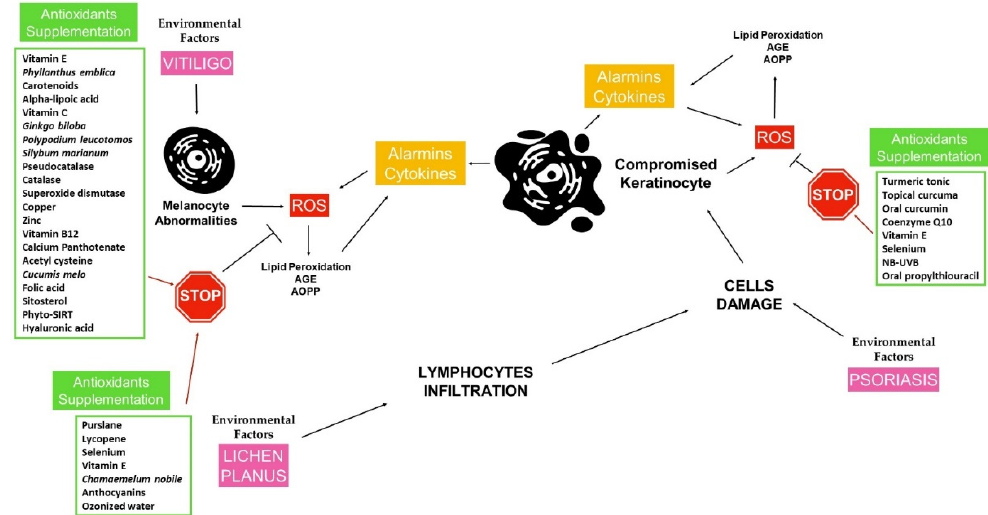
Figure 1. Environmental factors have a key role in triggering a cascade role, leading to the damage of skin cells. These events have a fundamental role in the oxidative stress/inflammation axis, which amplifies skin alteration, resulting in the worsening of the cutaneous disorders. Pro-inflammatory cytokines, together with alarmins and ROS, sustain the loop at the base of vitiligo, psoriasis, and lichen planus. In this scenario, the molecules reviewed seem to have a potential antioxidant effect.